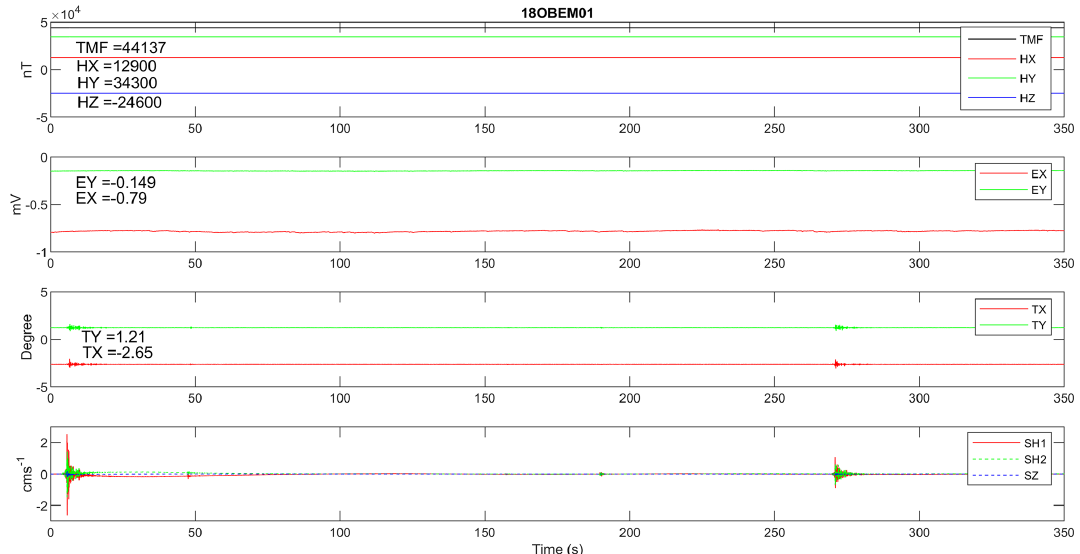
Figure 13. Comparison of the OBEM01 and 1802OBS time series data during the two earthquakes. The two earthquakes affected the inclinations. The first and secondary earthquakes occurred at 12:41 and 12:47UTC, respectively, on 27 April 2018. SH1 and SH2: two horizontal components of the seismic signal; SZ: vertical component of the seismic signal.